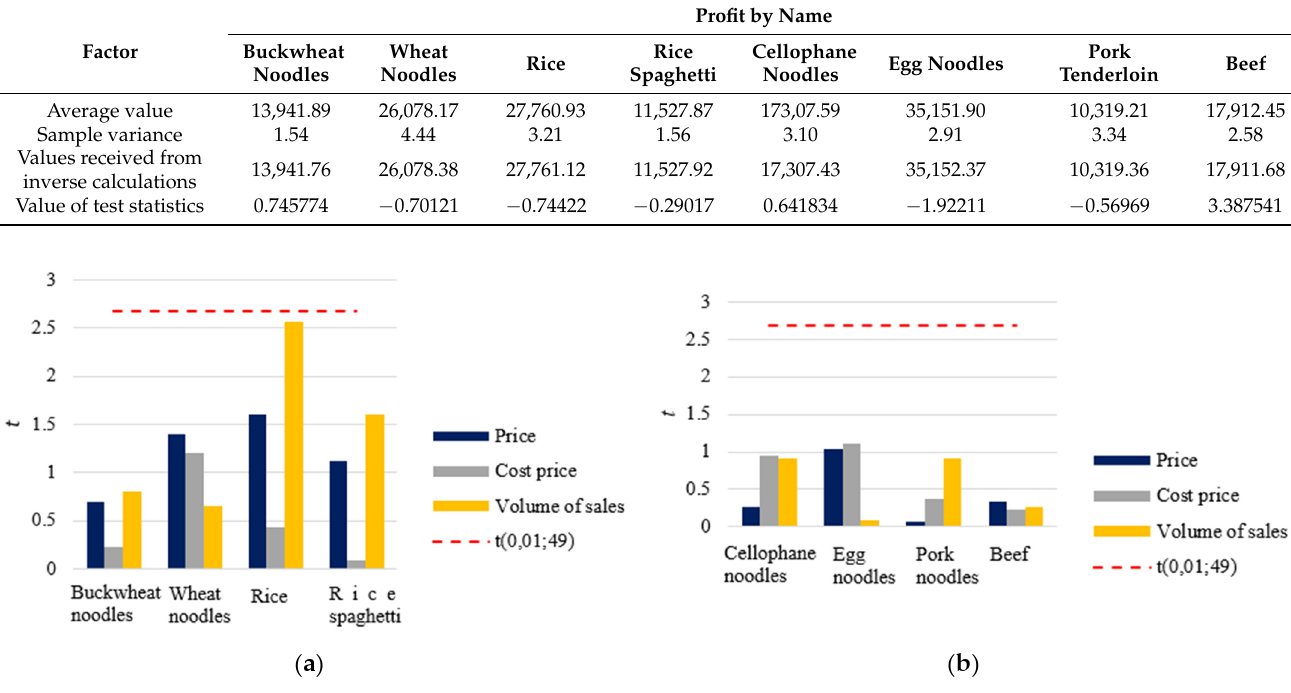
Figure 15. Calculated values of statistics: ( a ) for the first four items; ( b ) for the last four items.